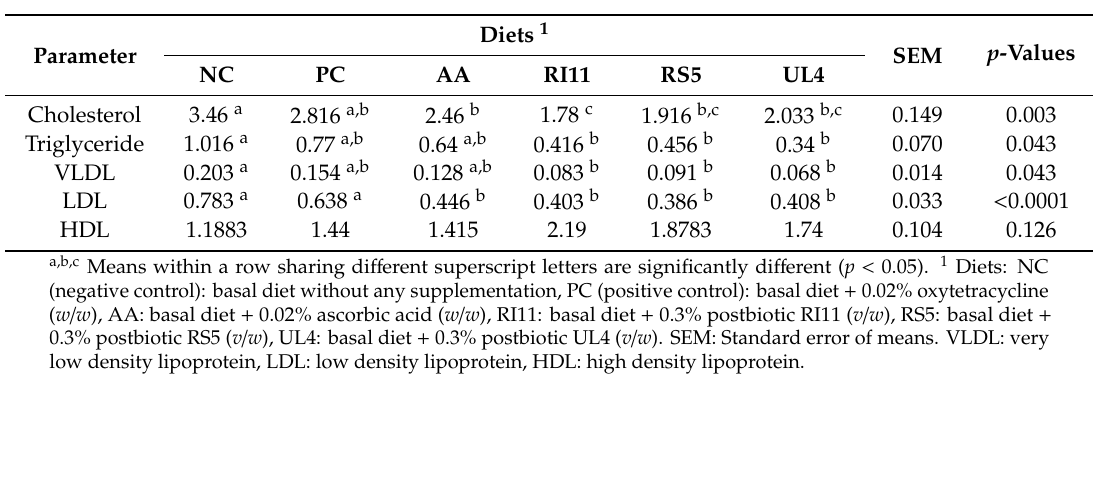
Table 2. Plasma lipid profiles (mmol / L) in heat-stressed broiler chickens fed with three di ff erent postbiotics. Parameter